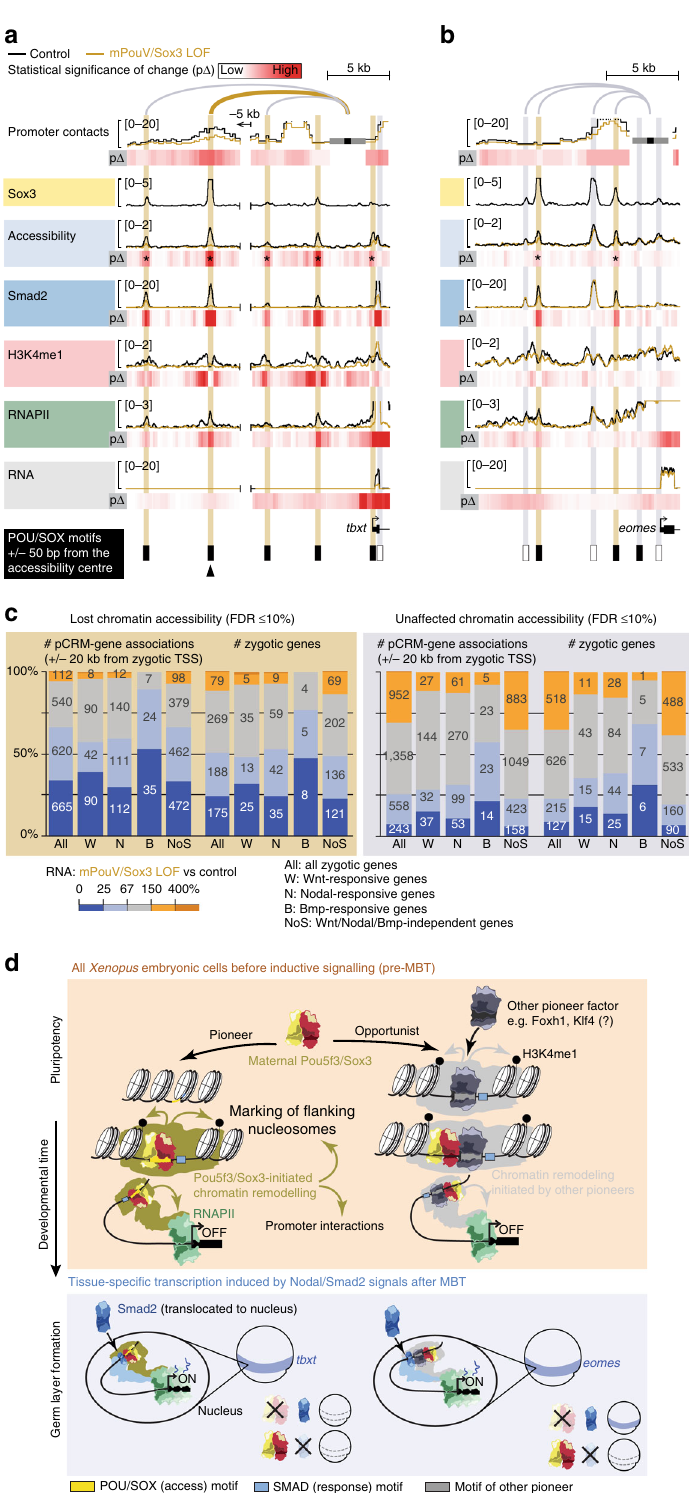
All: all zygotic genes W: Wnt-responsive genes N: Nodal-responsive genes B: Bmp-responsive genes NoS: